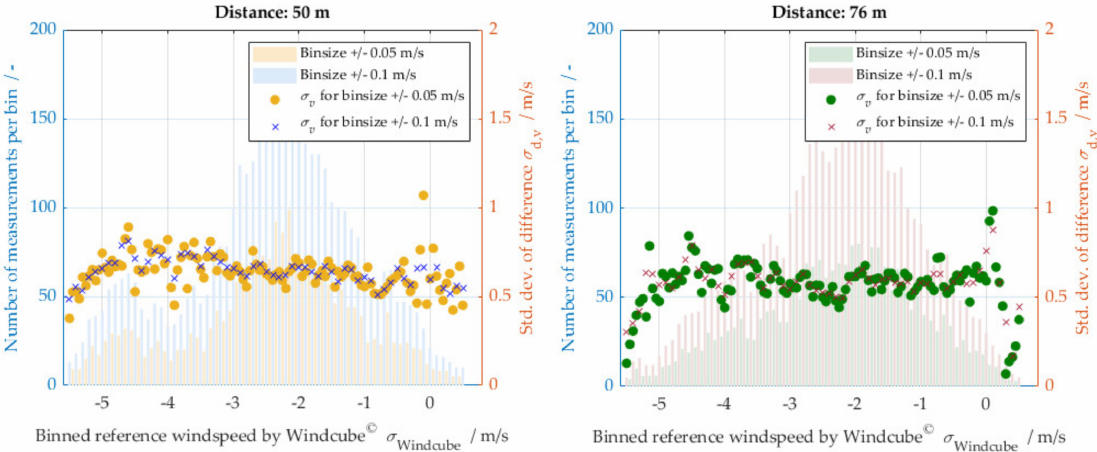
Figure 10. Analysis of the slope error of wind measurement by evaluating wind bins.